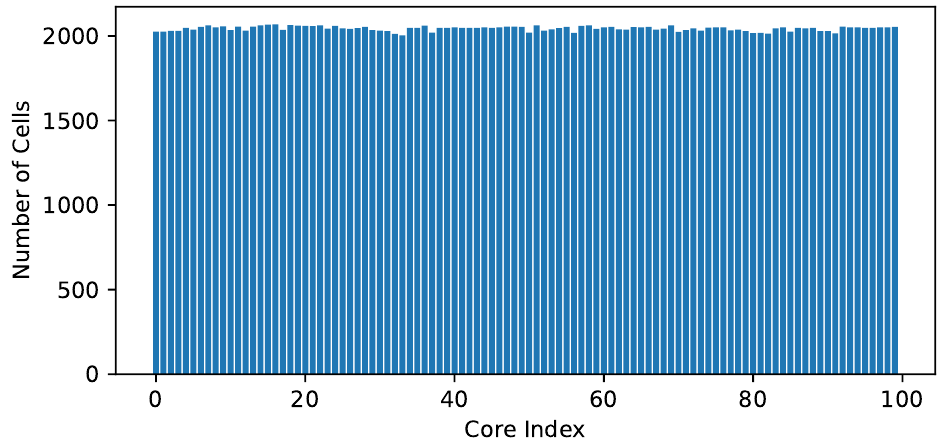
Figure 25. Distribution of cells in the mesh partitioning given in Figure